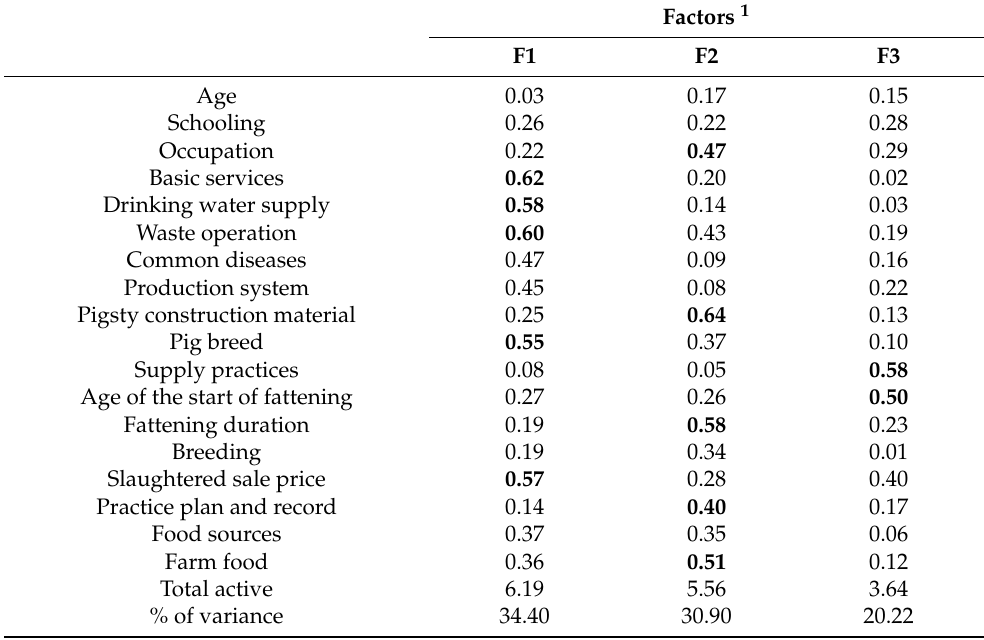
Table 5. Factors of multiple correspondence